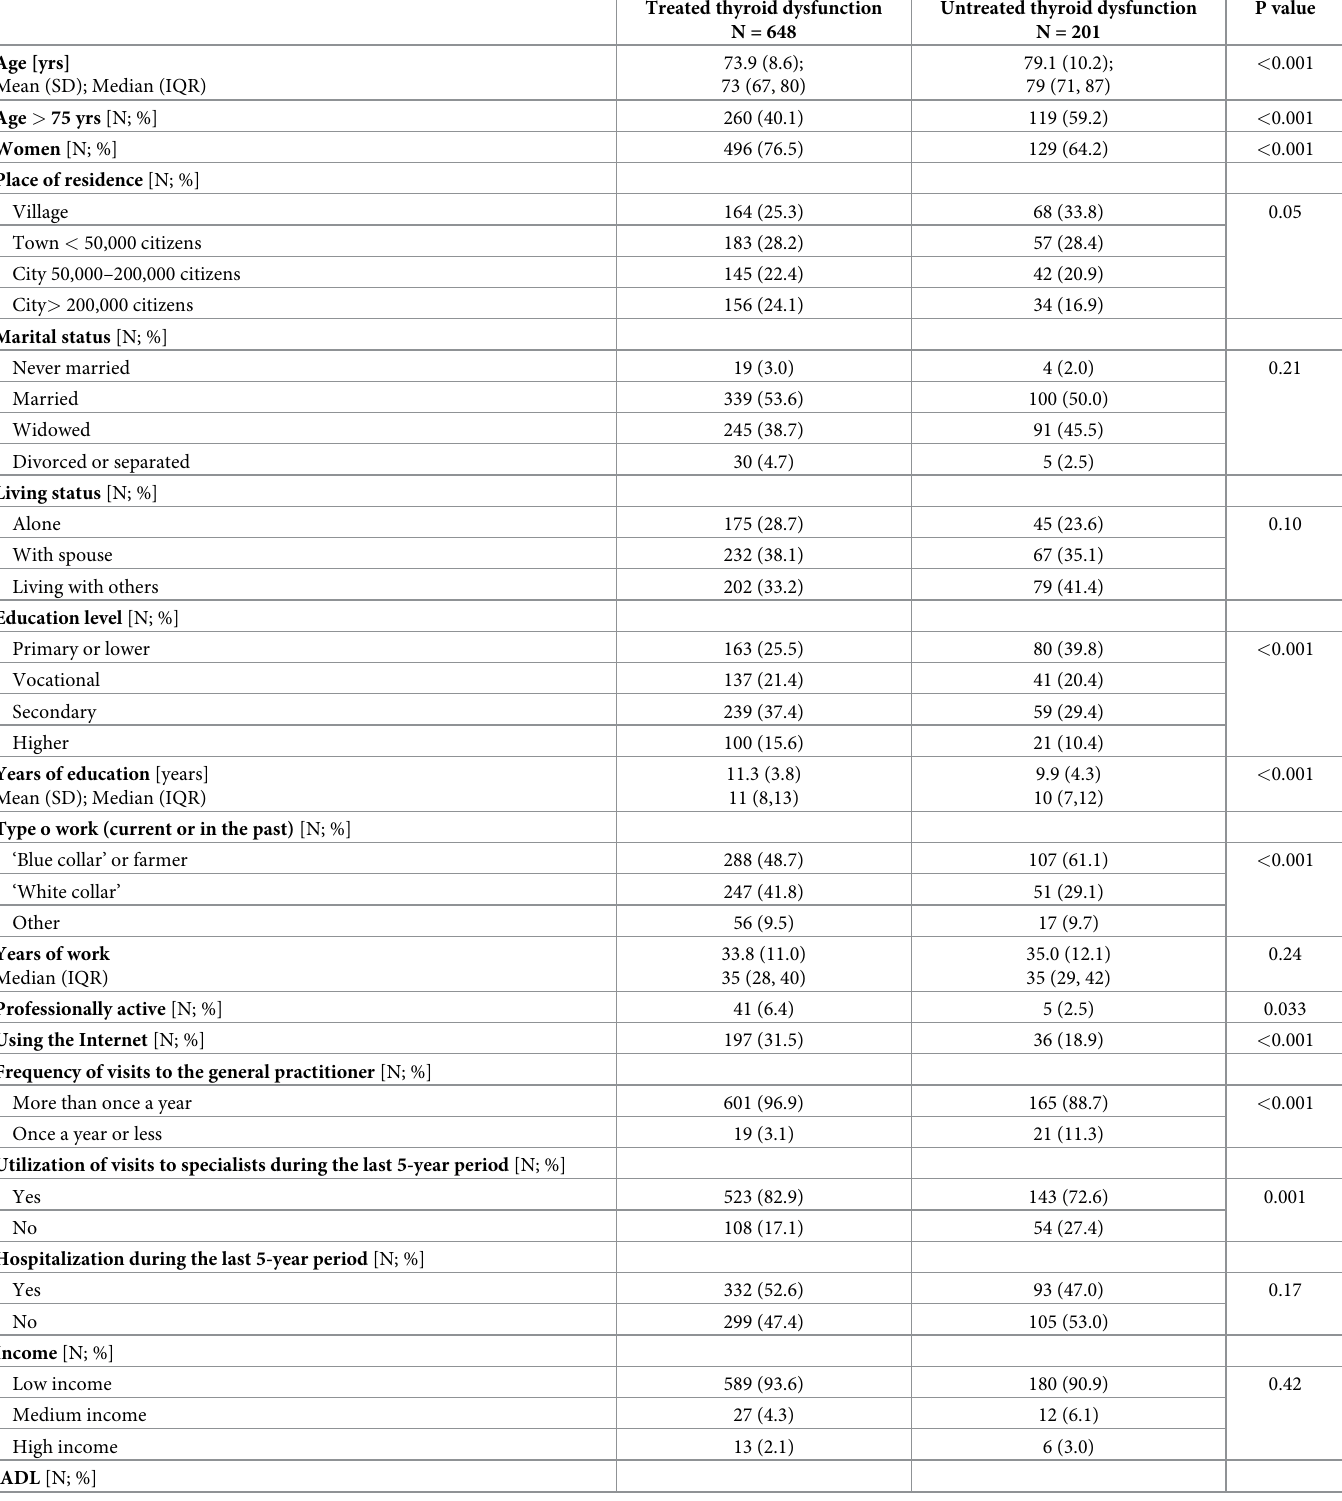
Table 1. Comparison of subjects with treated and untreated thyroid